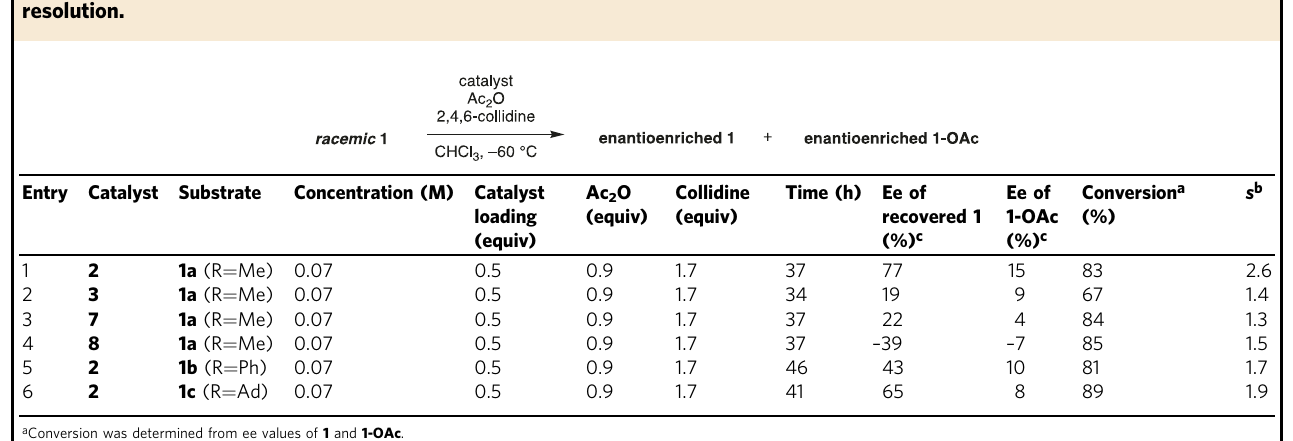
Table 1 Kinetic resolution of racemic rotaxanes: effects of the substrate structure and catalysts on the selectivity of kinetic